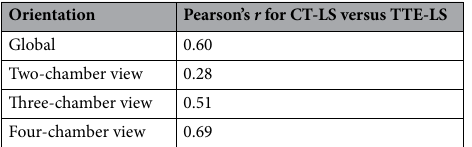
Orientation Pearson’s r for CT-LS versus TTE-LS Global 0.60